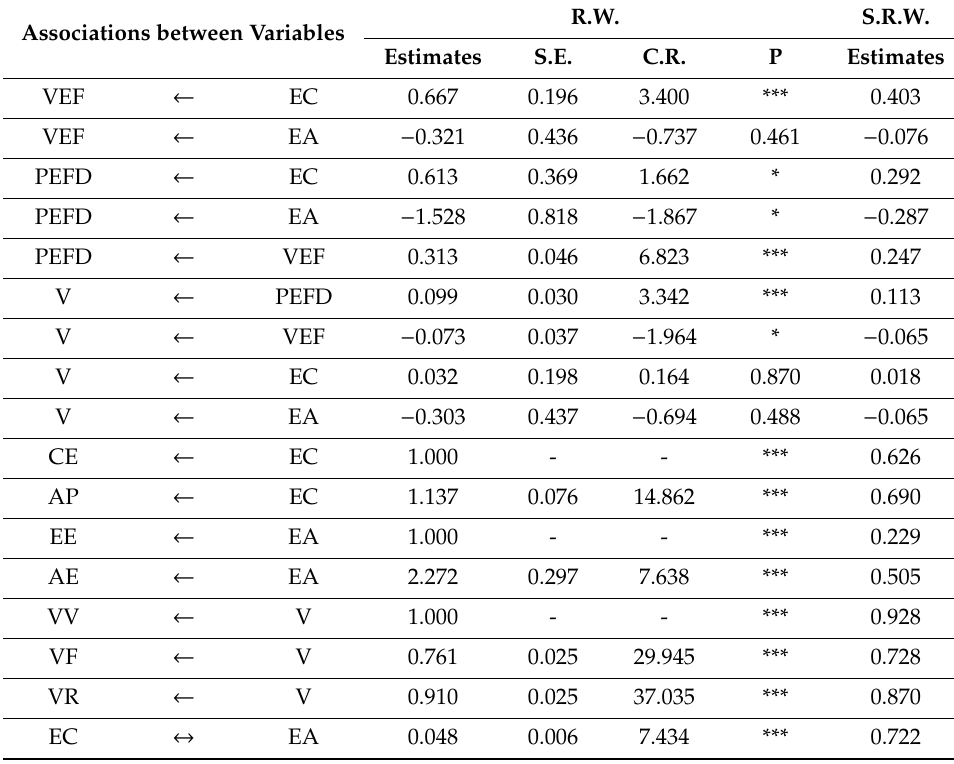
Table 2. Structural model for sedentary participants. Associations between